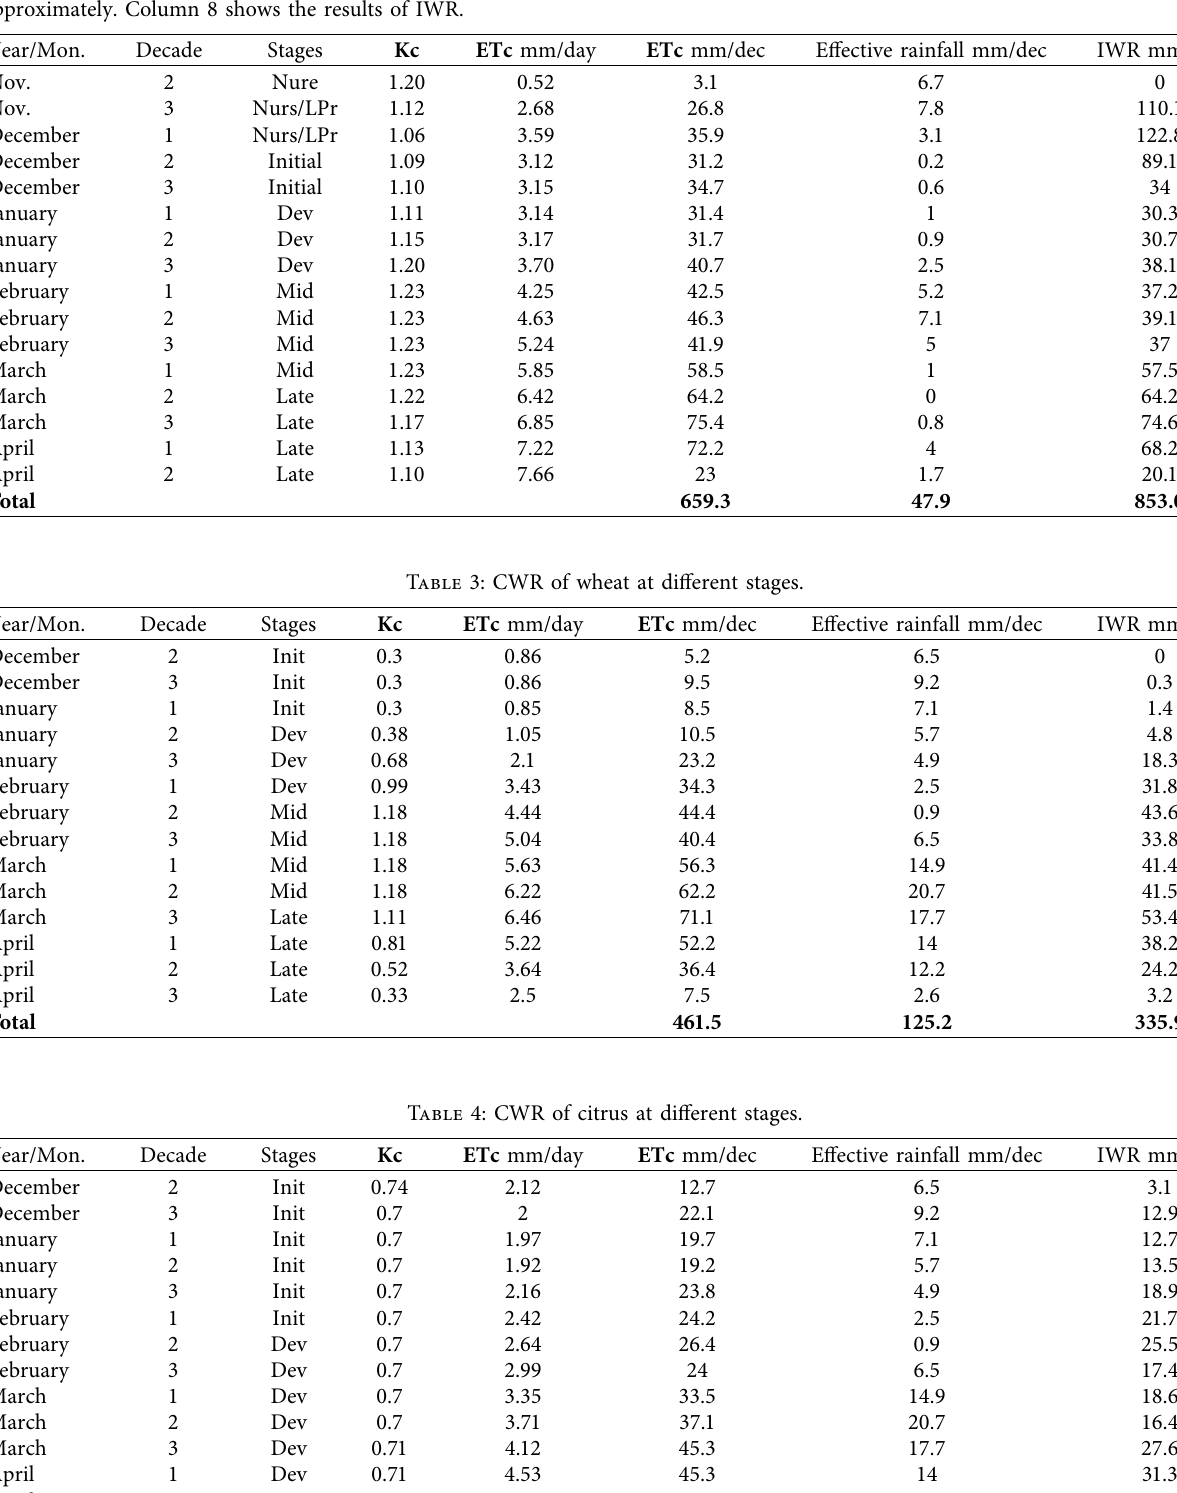
Table 2: Results shows CWR to rice at different stages; the total time taken from nursery/land preparation to end stage is 150 days approximately. Column 8 shows the results of IWR.